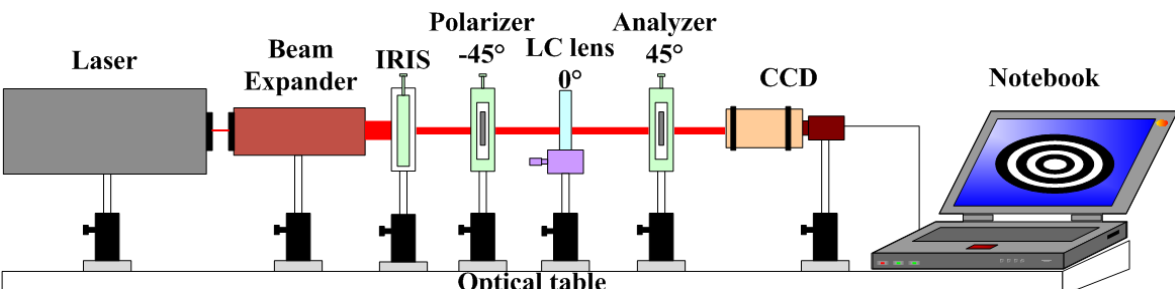
Figure 4. The experimental